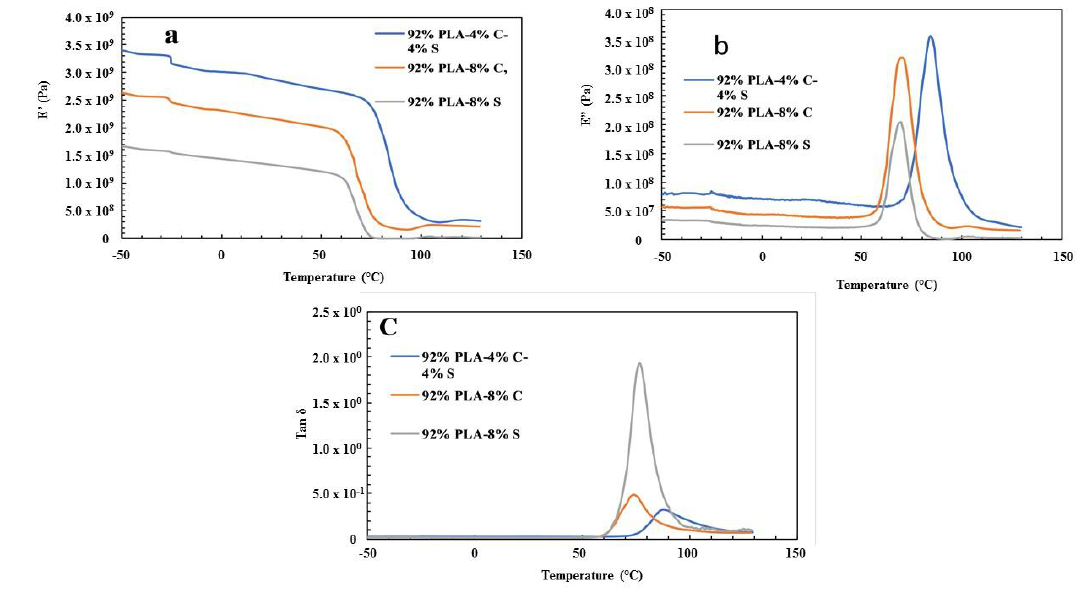
Figure 2. ( a ) Storage modulus (E’); ( b ) loss modulus (E”); ( c ) loss factor tan δ for 92% PLA–4%